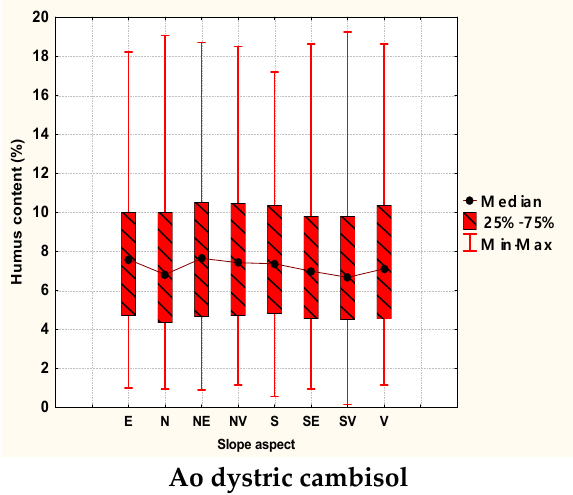
Figure 2. The variation of soil organic matter content in Ao horizon of dystric cambisol.